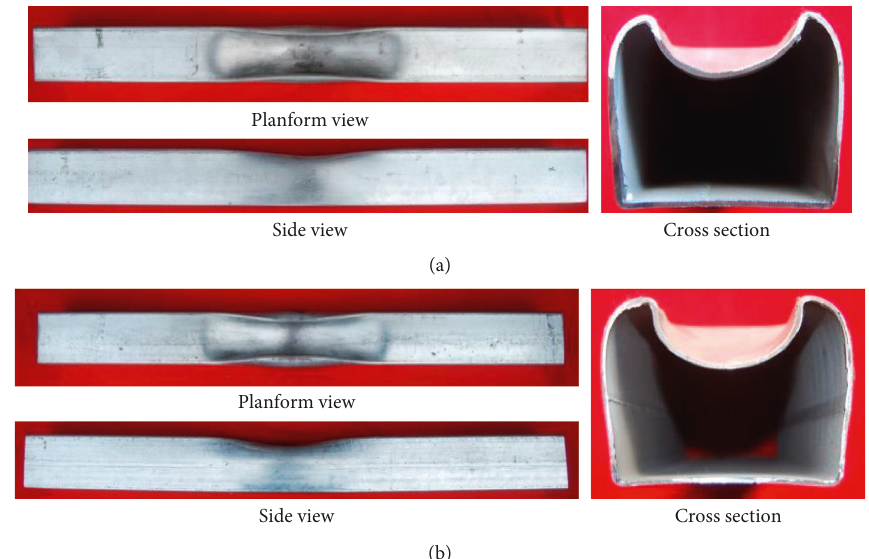
Figure 5: Typical failure modes of cylindrical shell in Mode Ia and Mode Ib. (a) Mode Ia: local plastic deformation without global deformation ( a � 3.0mm, R � 24cm, m � 100g + 160 g, TZ1). (b) Mode Ib: local plastic deformation with small global deformation ( a � 3.0mm, R � 20 cm, m � 100g + 160g, TZ5).